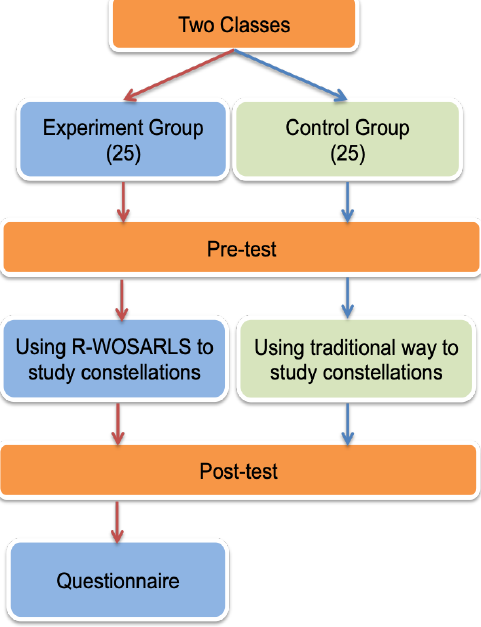
Figure 13. The experimental procedure of the teaching experiment at a junior high